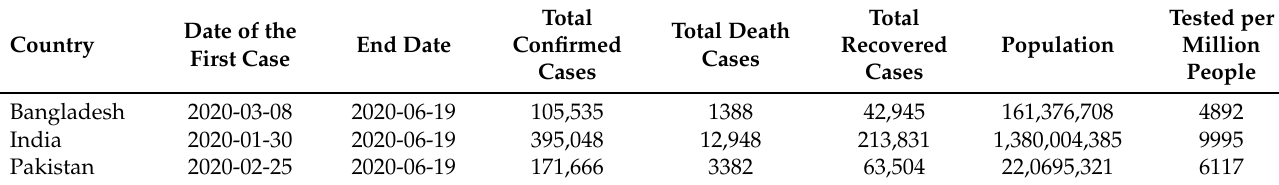
Table 1. COVID-19